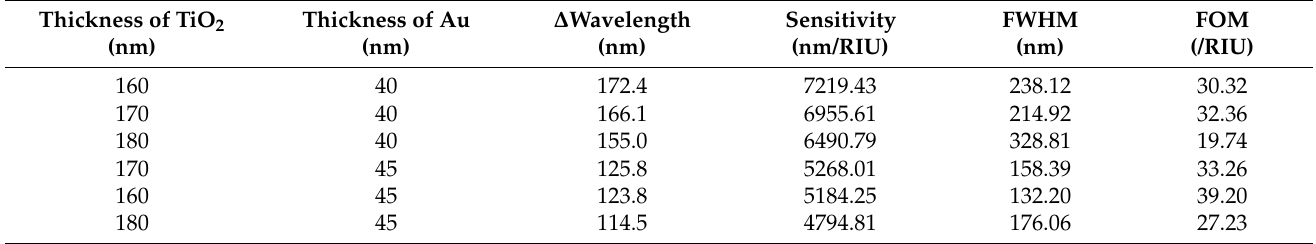
Figure 5. The RI response of the TiO 2 -Au SPR sensor at different thicknesses of gold film and TiO 2 film. Table 1. Sensitivity, FWHM, and FOM data of the TiO 2 -Au SPR sensor.